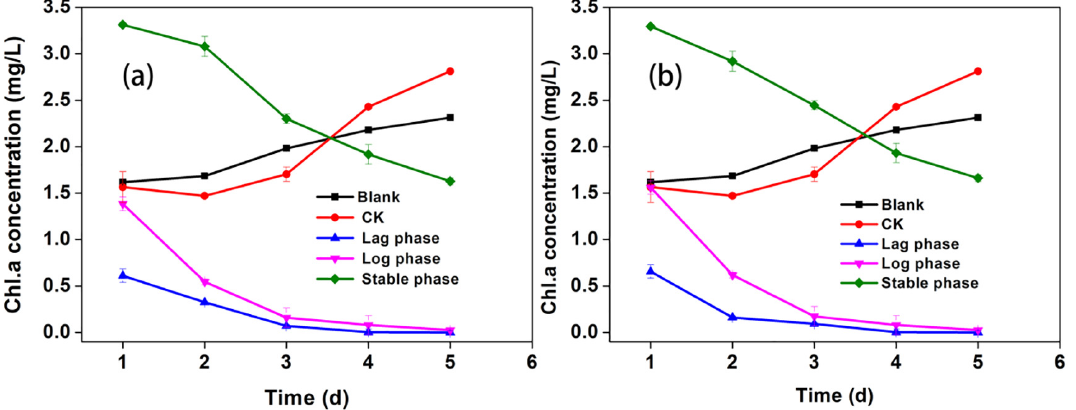
Figure 6. The algicidal effects of bacterial on Microcystis aeruginosa in different growth phases . ( a ) strain 39 # and ( b ) strain 91 # .